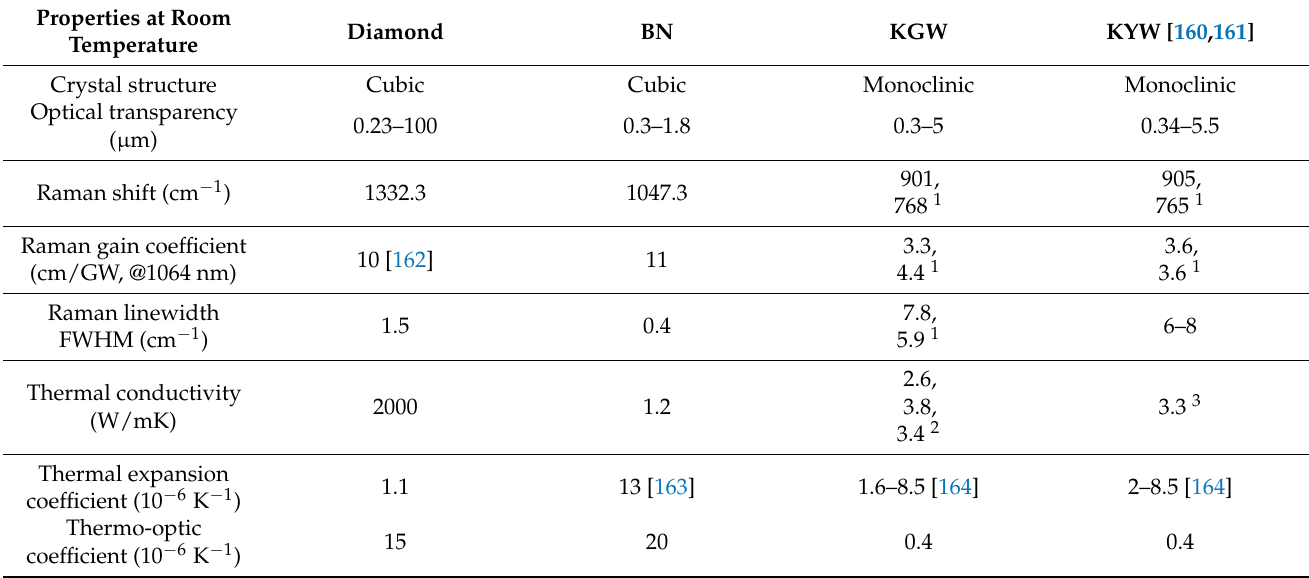
Table 5. Comparison of material properties of Raman crystals